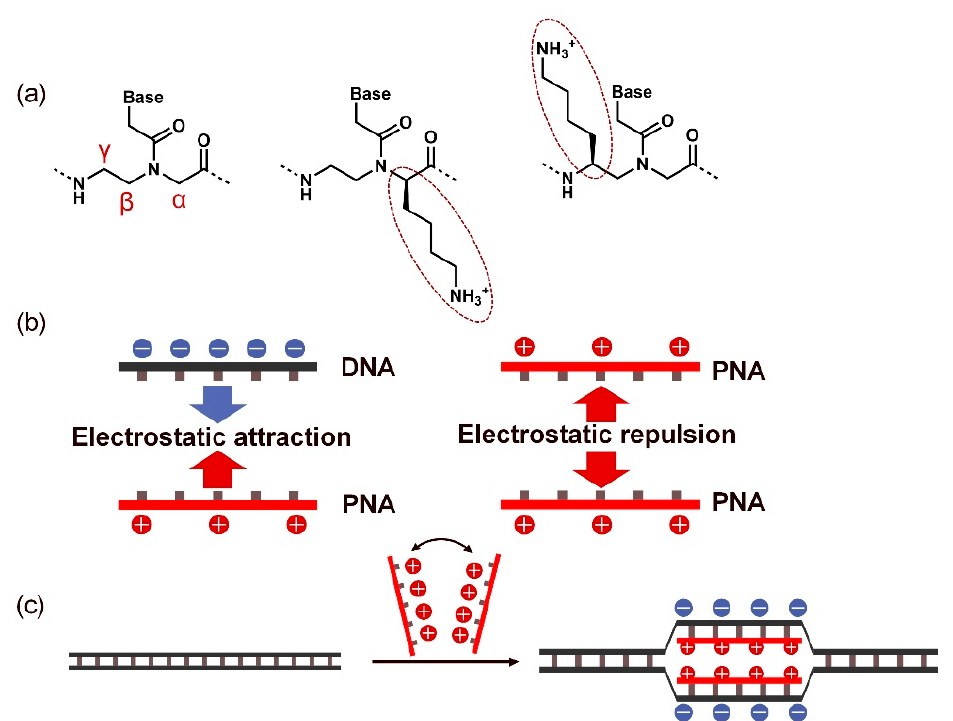
Figure 6. ( a ) Structures of PNAs with chiral backbone. ( b ) Enhancement of DNA affinity and suppression of self-duplex formation through electrostatic interaction by cationic PNAs. ( c ) The promotion of double-duplex invasion by introducing positive charges to PNA strands.